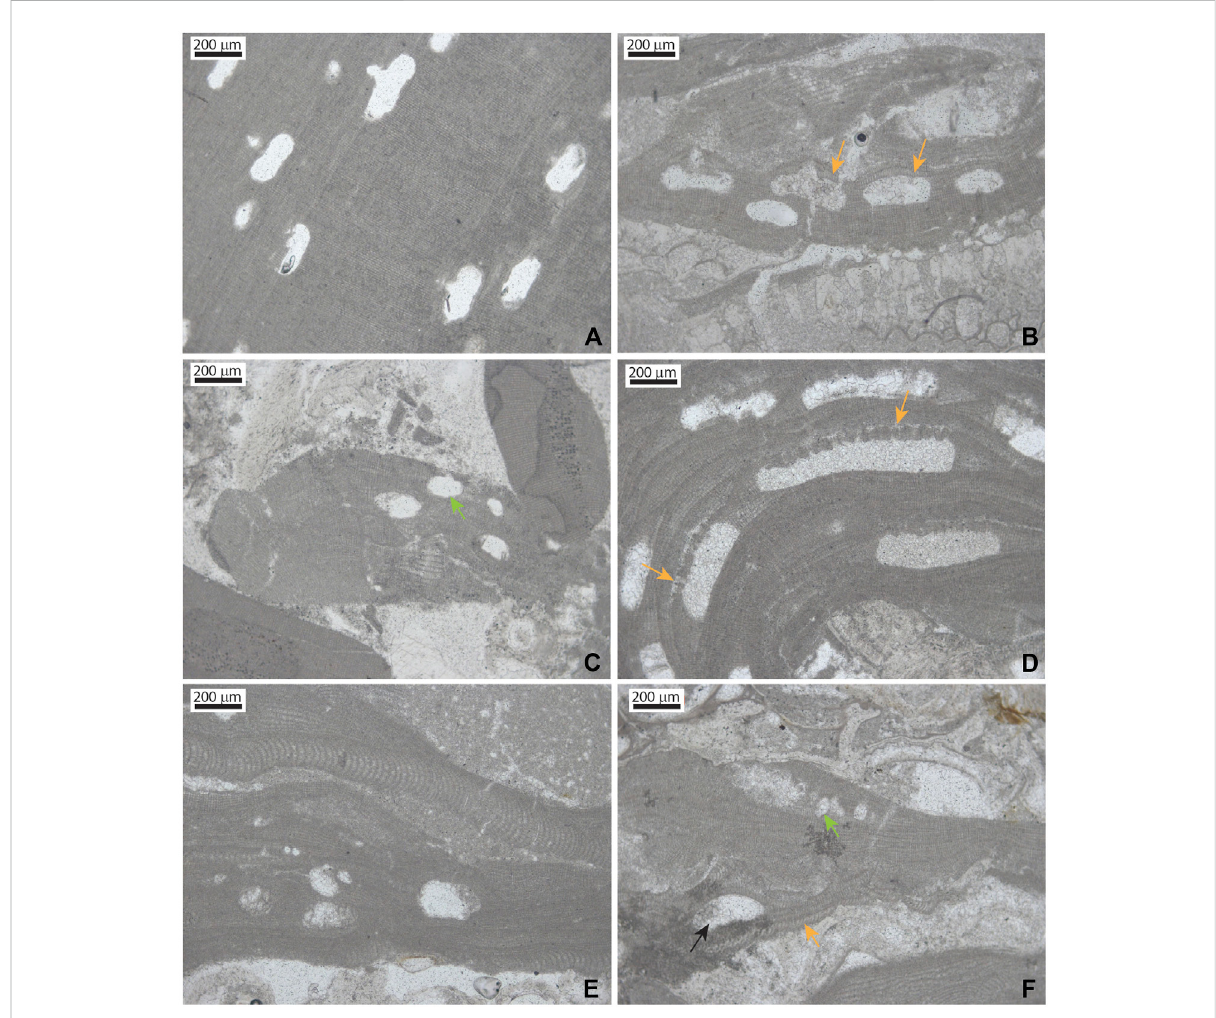
FIGURE 7 Micrographs of selected taxa in the coralline algal assemblages in the Acinipo limestone. (A) Lithophyllum gr. incrustans . Peripheral region with sporangial conceptacles. (B) Lithophyllum gr. nitorum growing on a bryozoan colony. Note the characteristic long cells in the conceptacle roof of the sporangial conceptacles. (C) Thallus fragment of Lithophyllum gr. orbiculatum . Note the small size of sporangial conceptacles (arrow) and the poorlateralalignmentofcellsofadjacent fi laments. (D) Sectionofashortprotuberanceof Lithothamnion gr. crispatum .Notethecharacteristic pits in the sporangial conceptacle roof (arrows). (E) Thalli/branches of Mesophyllum gr. curtum with characteristic small-sized sporangial conceptacles with ahexagonal section. (F) Lithophyllum gr. pustulatum (orange arrow)and Sporolithon sp.withasorusofsporangialcompartments (green